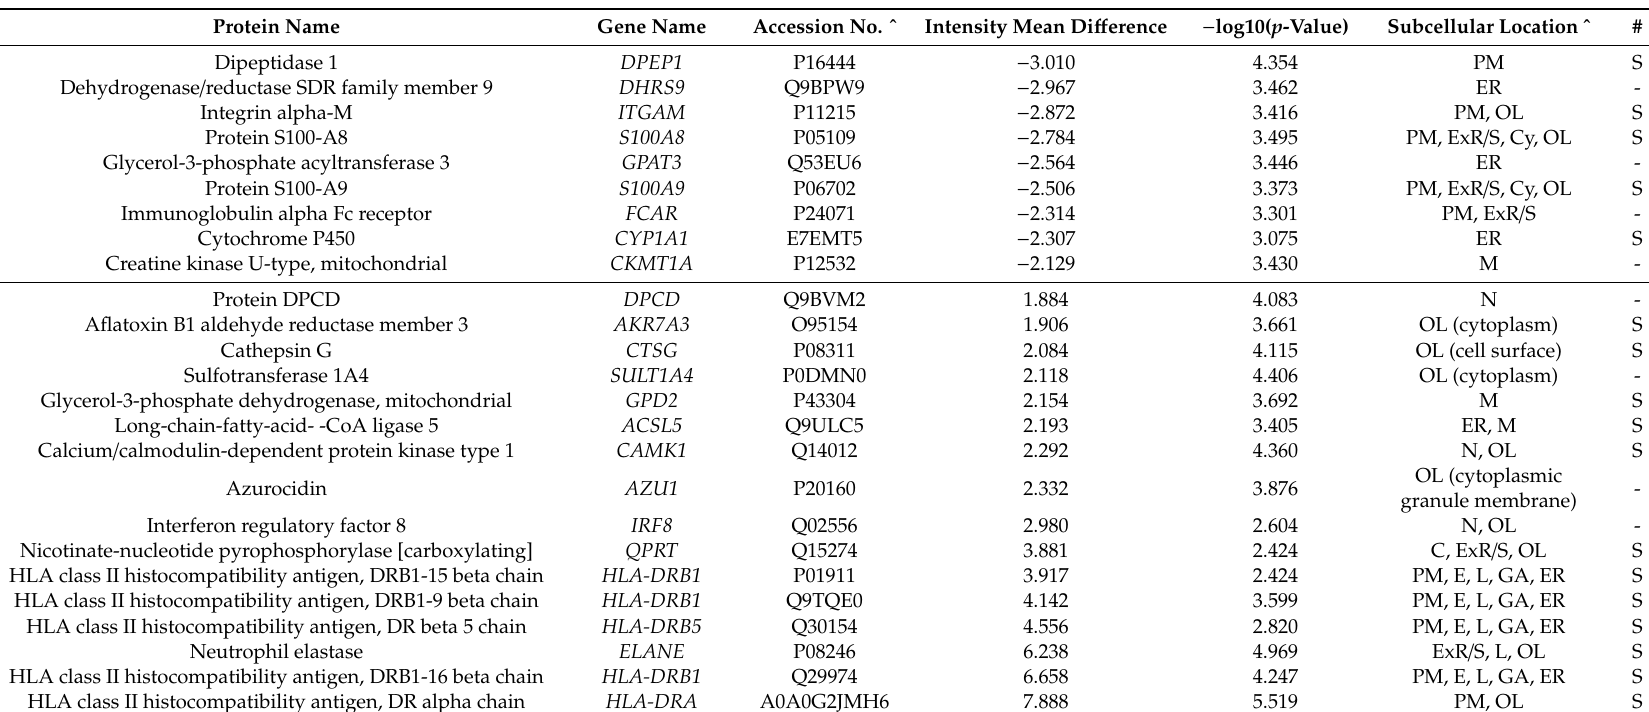
Table 4. LC-MS / MS identification results of di ff erentially expressed protein spots in U937 lysozyme-treated cells upon the two experimental schemes (LYS 24 h + 24 versus LYS 1 h +